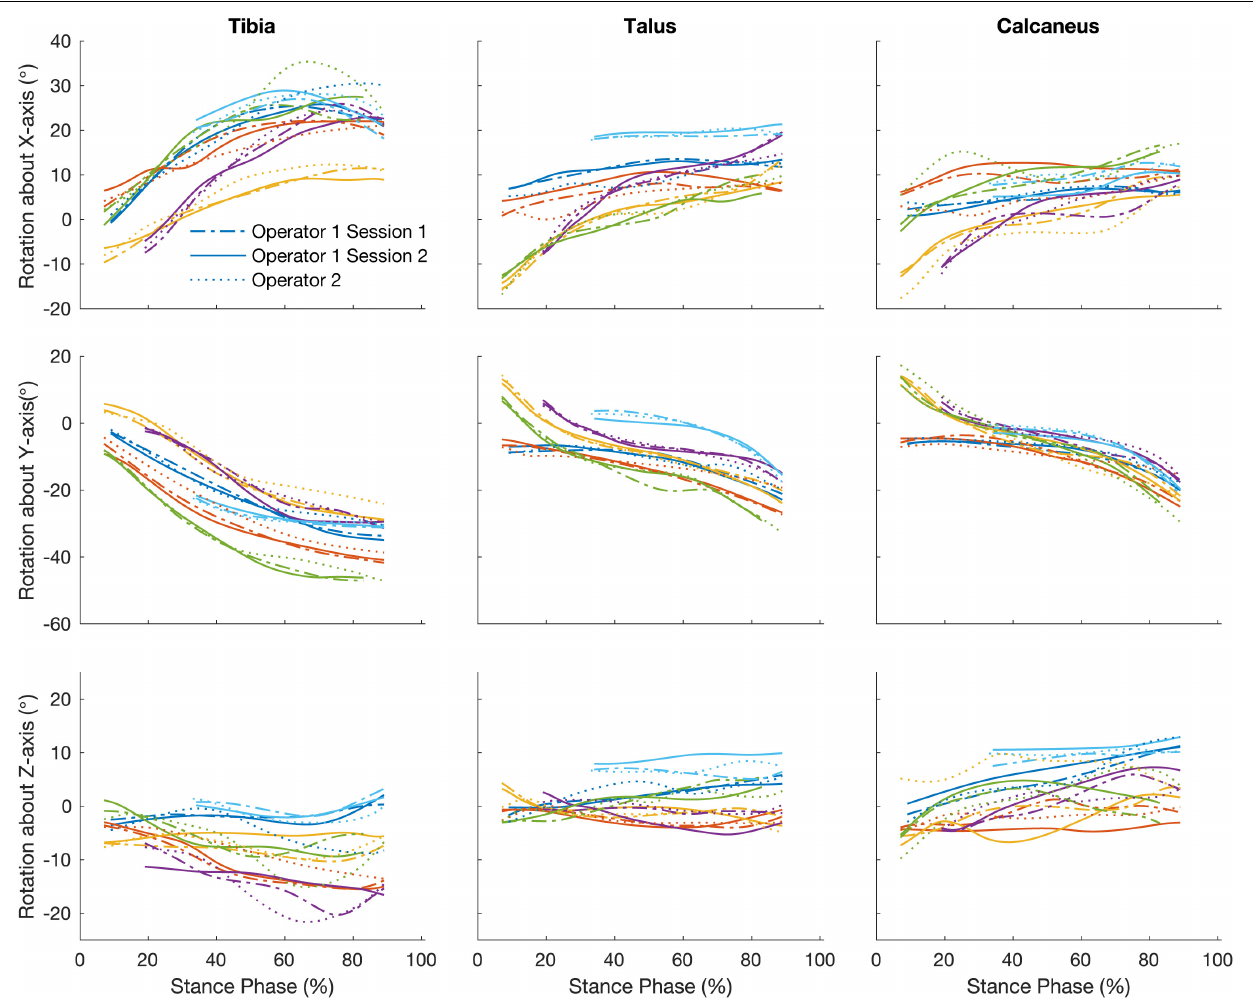
FIGURE 4 | Traces illustrate time normalized oreintation of tibia, talus, and calcaneus of each participant tracked by a single operator over two sessions, session 1 (dash line) and session 2 (solid line) and operator two (dotted line).